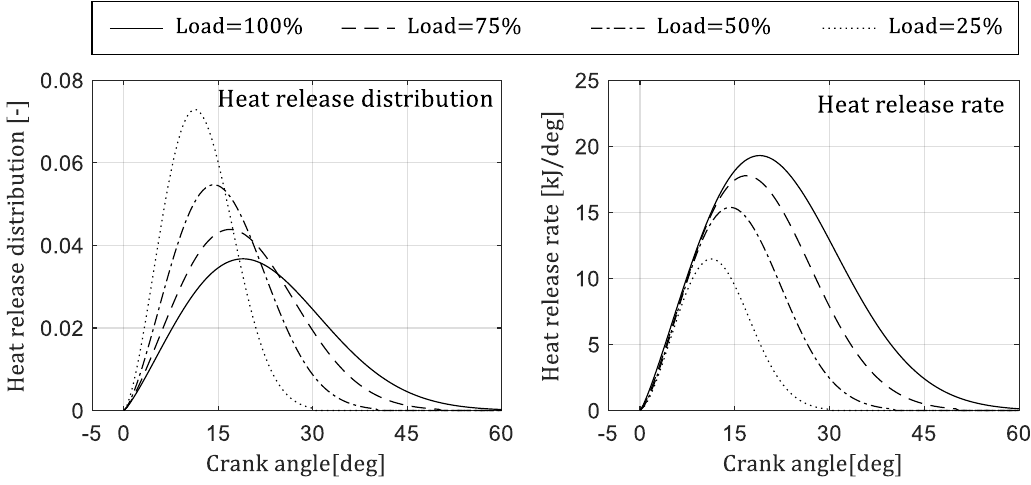
Figure 3. The heat release characteristics of the engine in liquid fuel mode with the SL model.